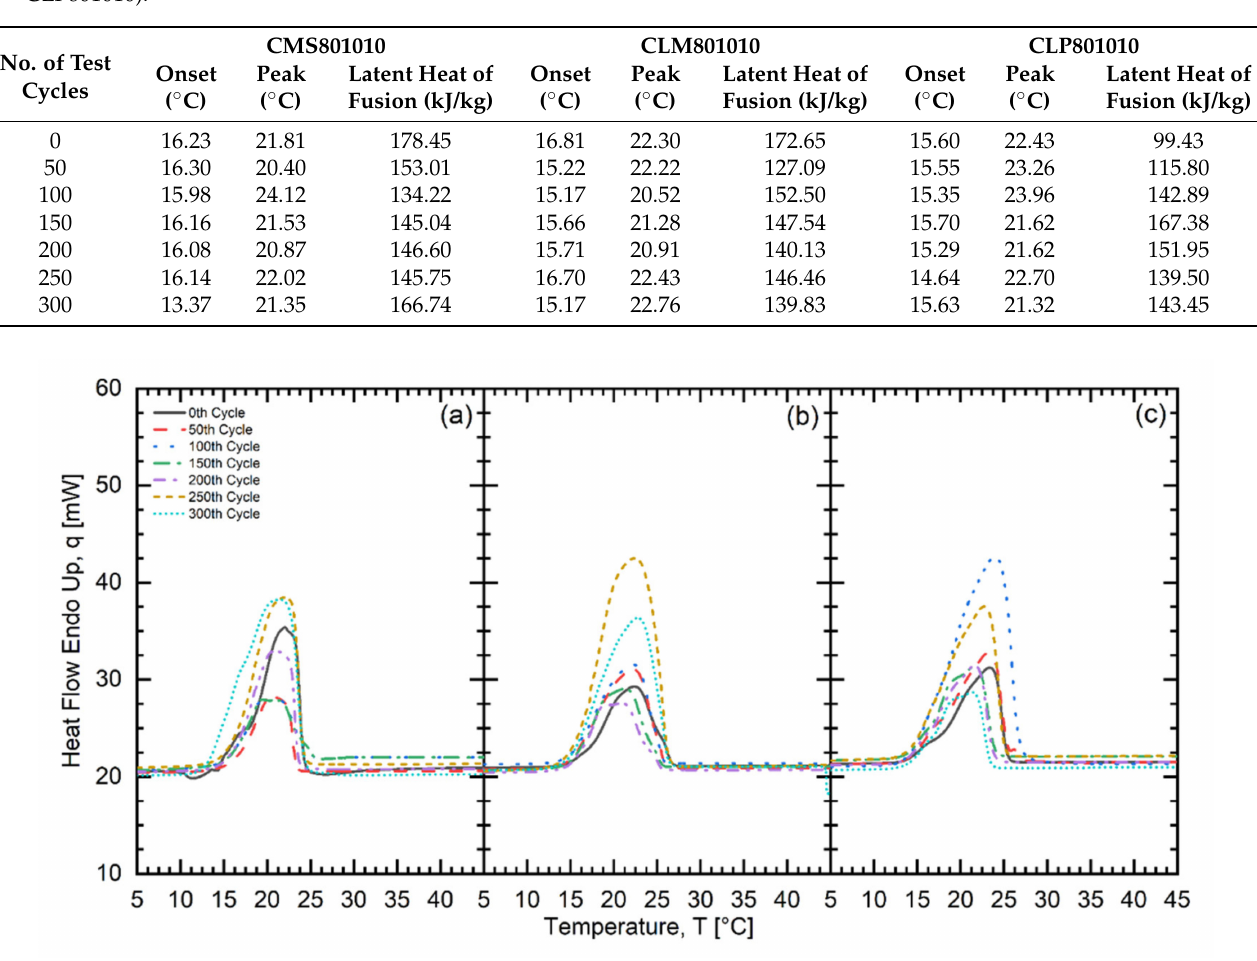
Table 7. Latent heat of fusion and melting temperature of developed materials with test cycles (CMS801010, CLM801010, CLP801010).